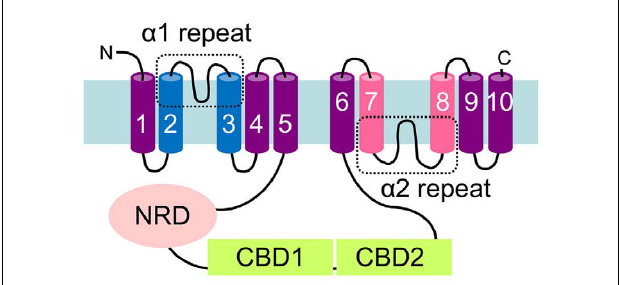
FIGURE 1 |Topological model of the Na + /Ca 2 + exchanger (NCX) protein. Barrel structures denote the transmembrane spanning domains identified by hydropathy analysis usingTMHMM version 2.The conserved α 1- and α 2-repeat regions which spanTM 2 and 3, andTM 7 and 8 are highlighted. The Ca 2 + -binding domains (CBD) and the predicted Na + regulatory domain (NRD) present on the large central cytosolic loop are